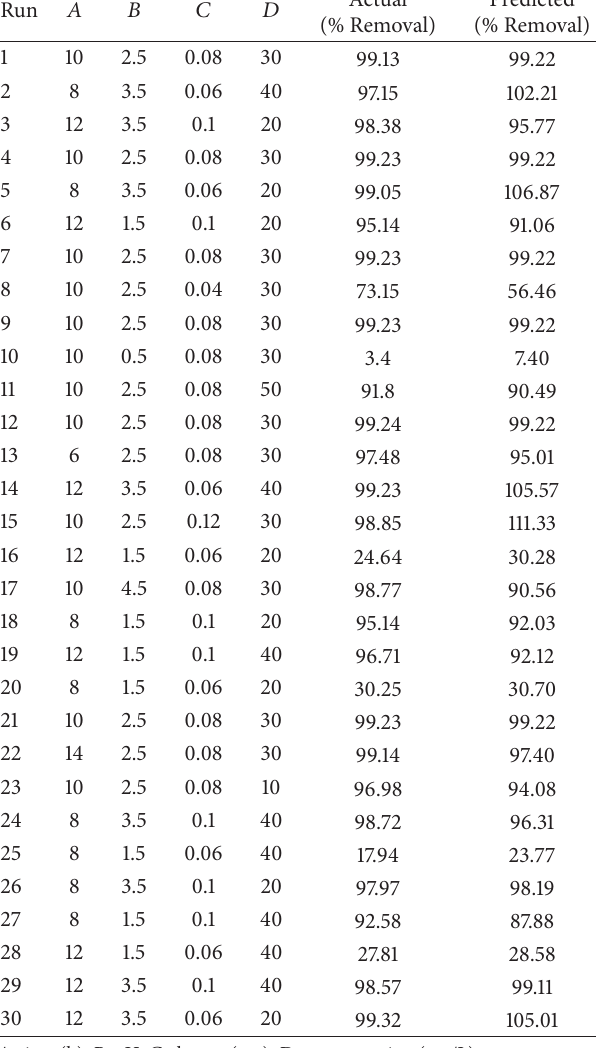
Table 2: Central composite rotatable quadratic polynomial model, experimental data, and actual and predicted values for five-level four-factor response surface analysis.